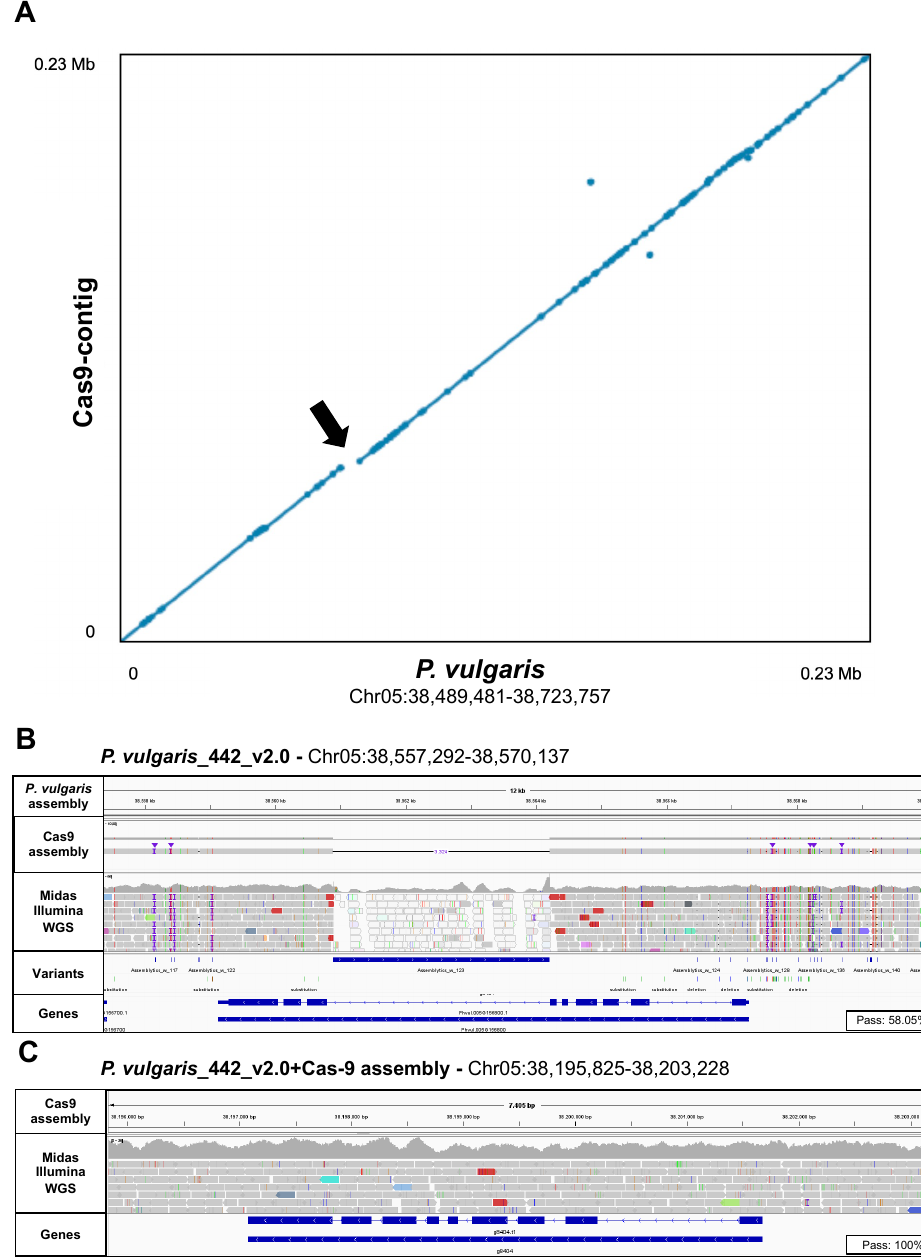
Figure 3. The pod-shattering region features multiple variations and a large deletion of 3 kbp overlapping a gene, when comparing the Midas cultivar and P. vulgaris reference genome. ( A ) The